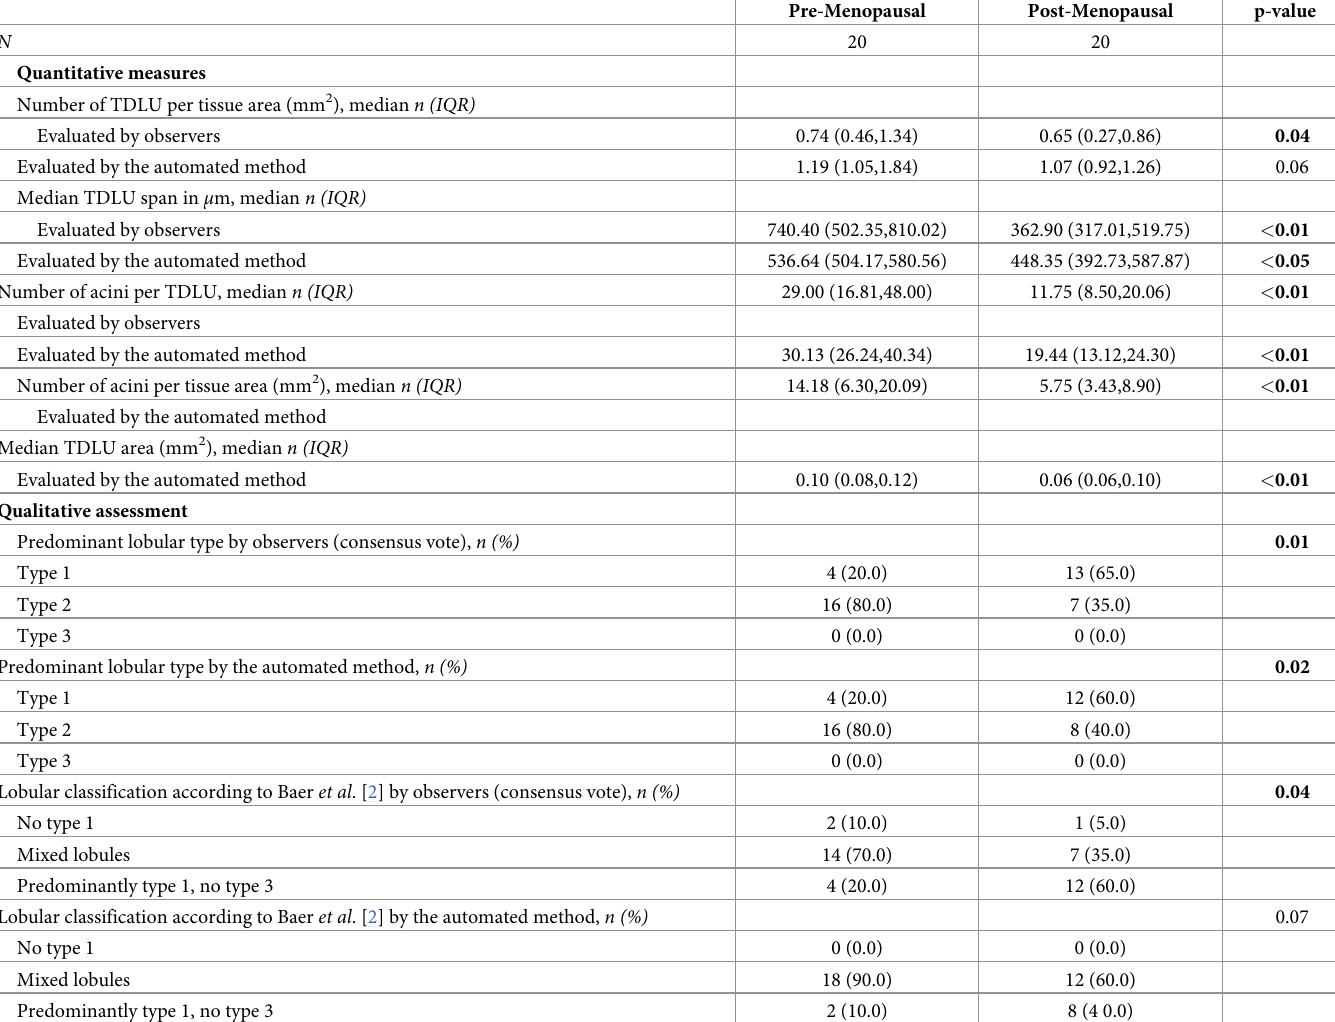
Table 4. The association of terminal ductal lobular unit (TDLU) involution measures and menopausal